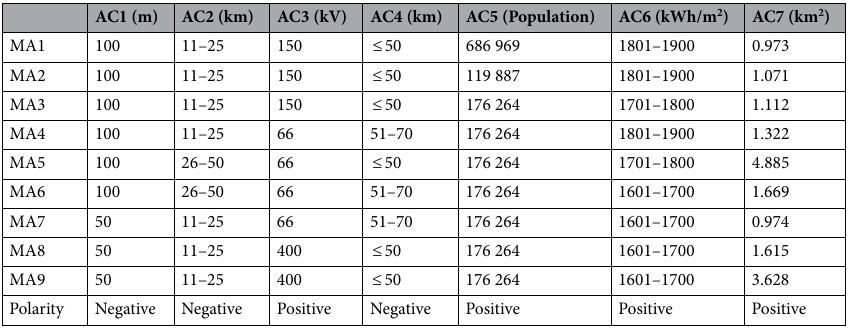
Table 1. Initial assessment